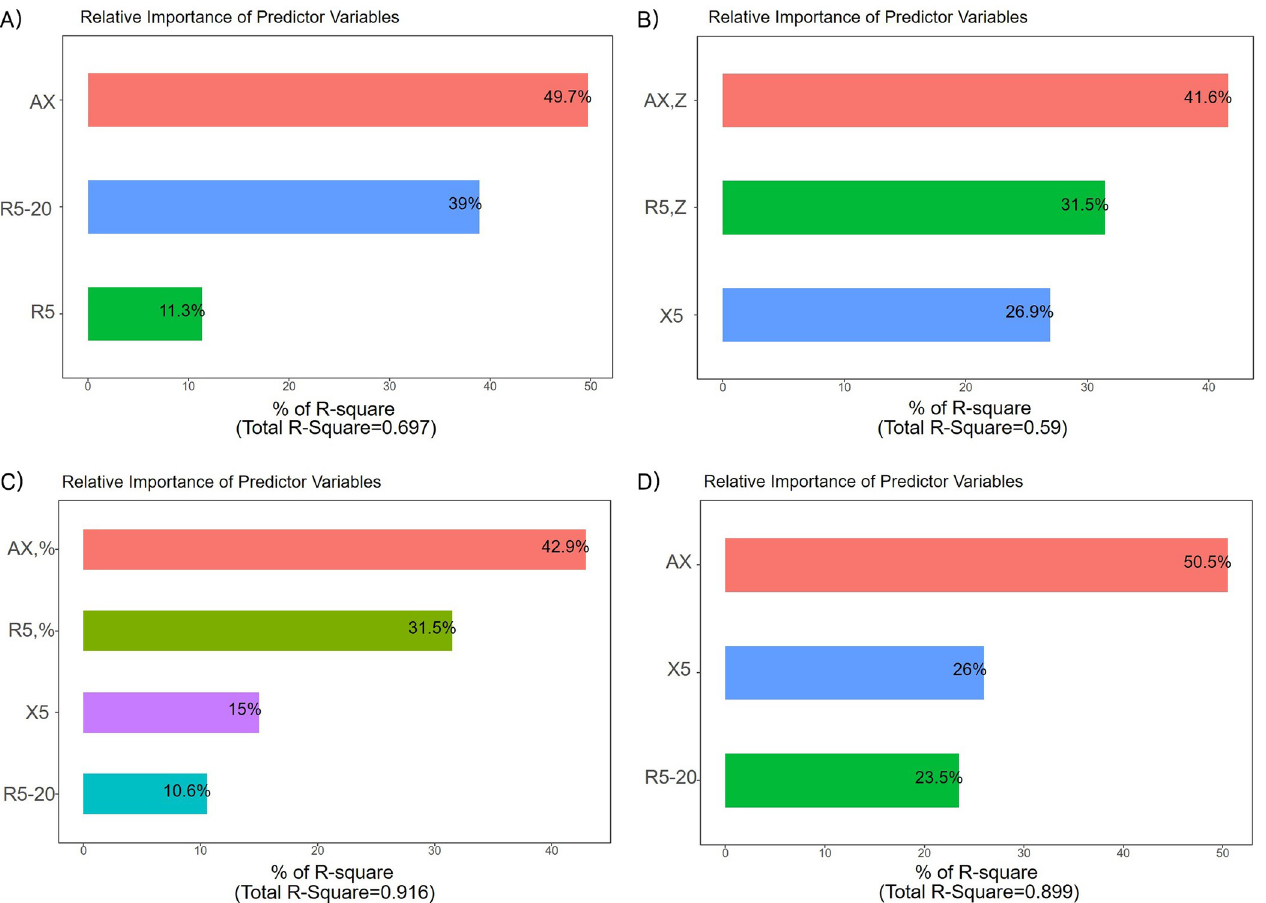
Fig 3. Relative importance as predictors of IOS variables for PFT parameters; A) FEV1 B) FEF25-75% C) Raw% (D) sRaw%.